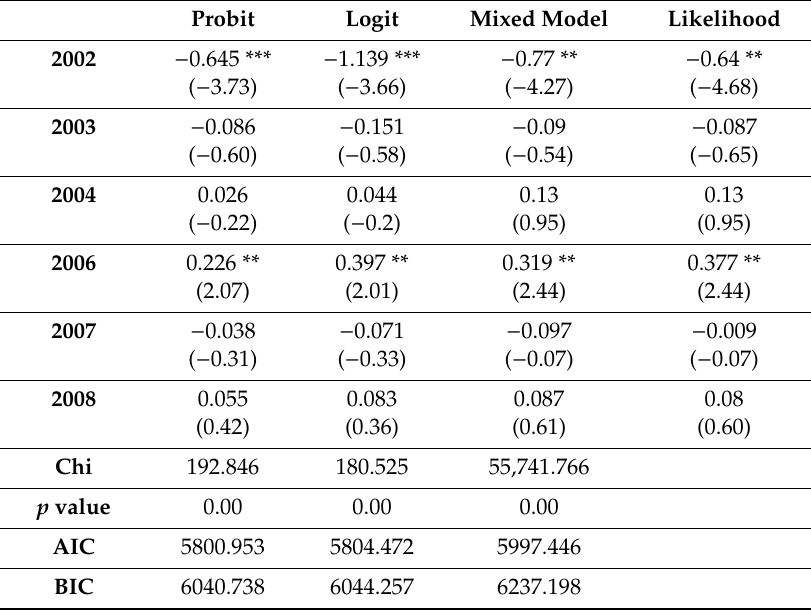
Table 4. Dynamic Model of Regression Analyses.